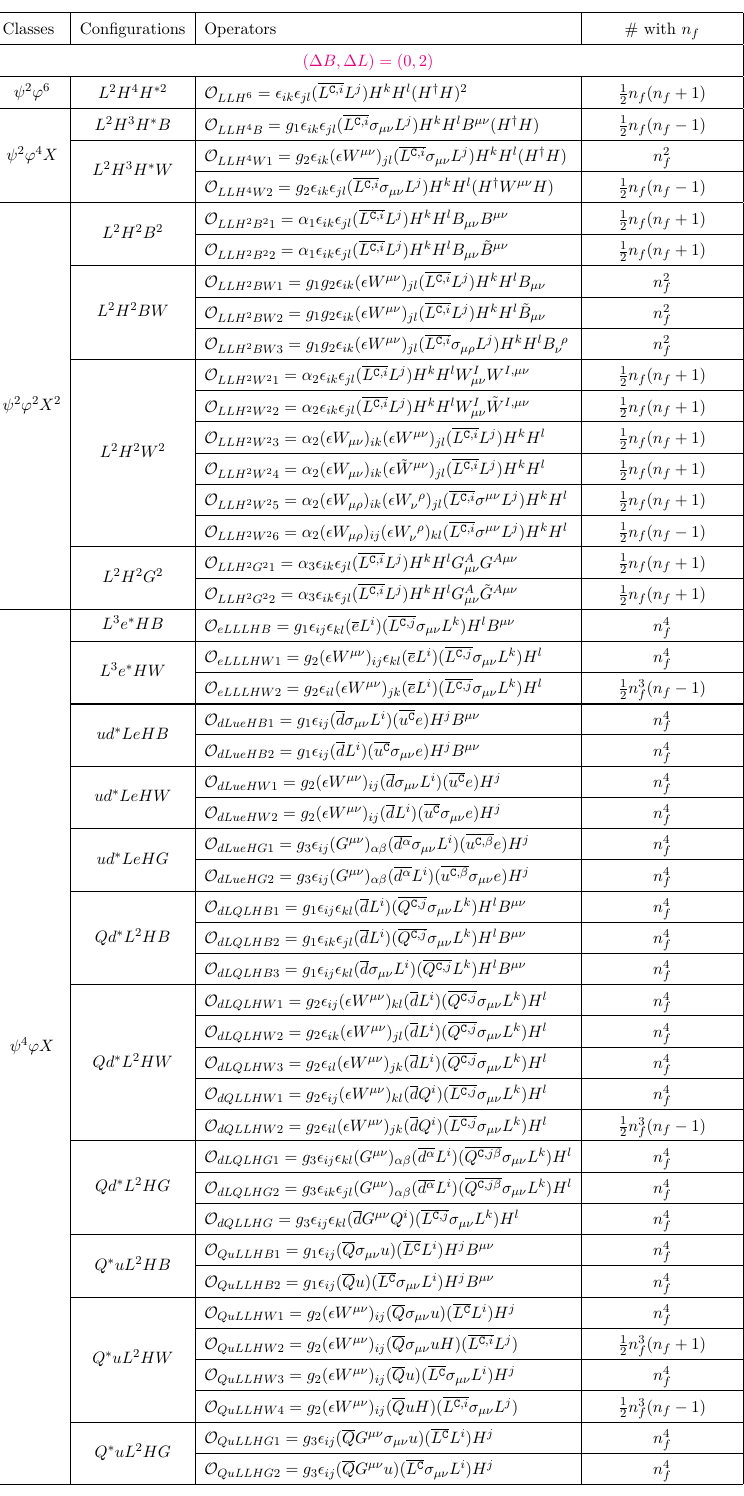
Table 2 . Dim-9 operators in classes ψ 2 ϕ 6 , ψ 2 ϕ 4 X, ψ 2 ϕ 2 X 2 , ψ 4 ϕX for sector (∆ B, ∆ L ) = (0 , 2) . There are 45 operators without counting fermion generations and 39 remain for one generation case. Hermitian conjugated operators are not included or